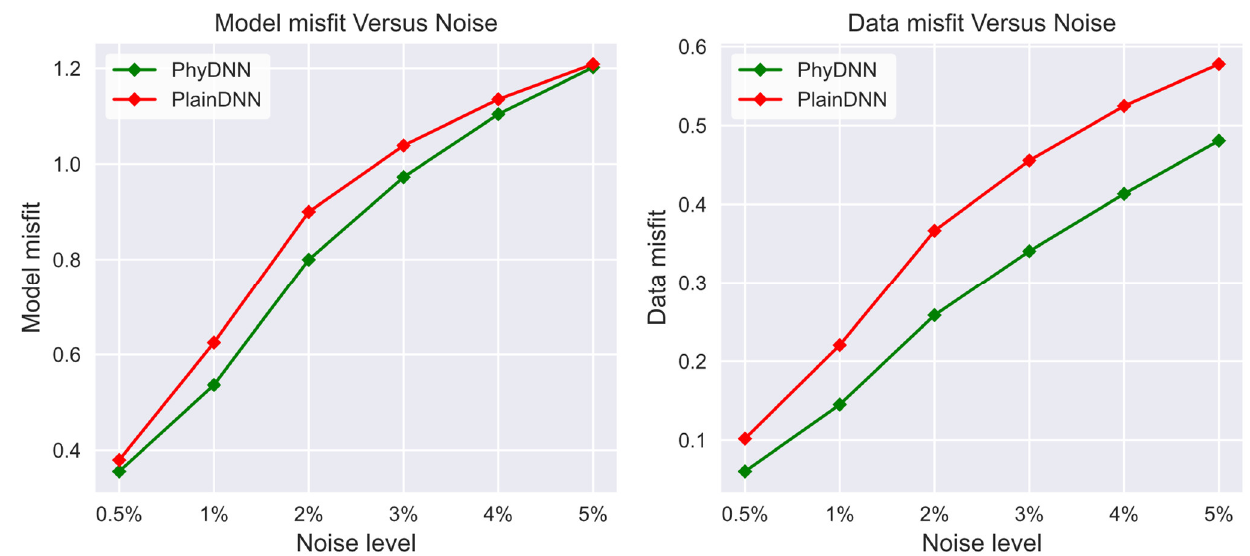
Figure 7. Comparison of the anti-noise performance between PhyDNN and PlainDNN at different levels of Gaussian noise. The left is the mean model misfit of the test set from PhyDNN and PlainDNN, and the right presents the mean data misfit of the test set from PhyDNN and PlainDNN.